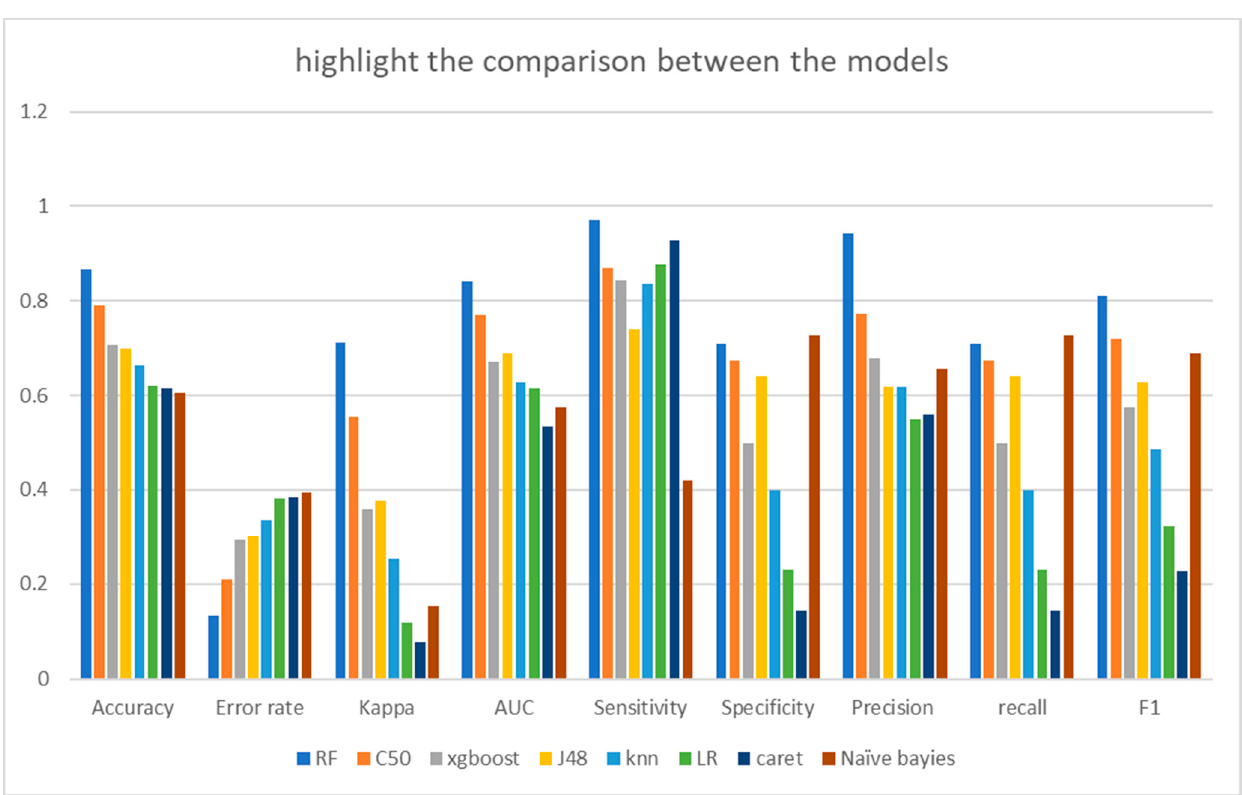
Figure 11. Comparison between the models.